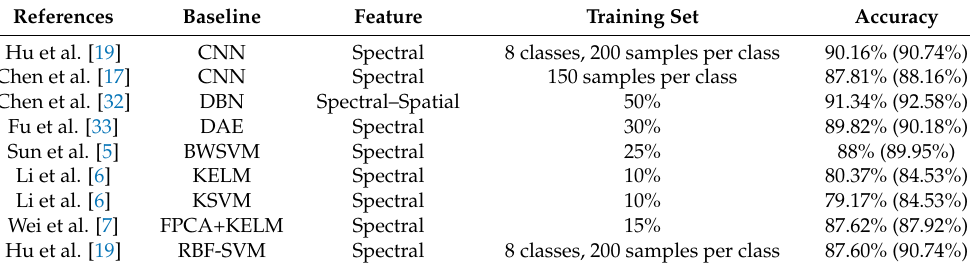
Table 11. Comparison with other methods for the Indian Pines dataset.